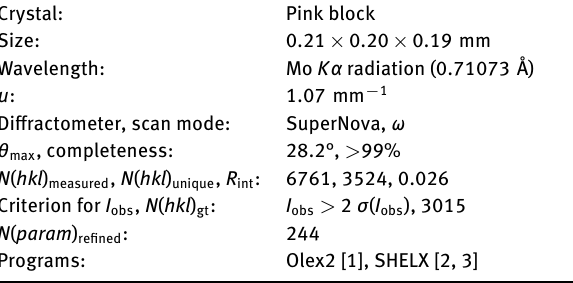
Table 1 contains crystallographic data and Table 2 contains the list of the atoms including atomic coordinates and dis- placement parameters.